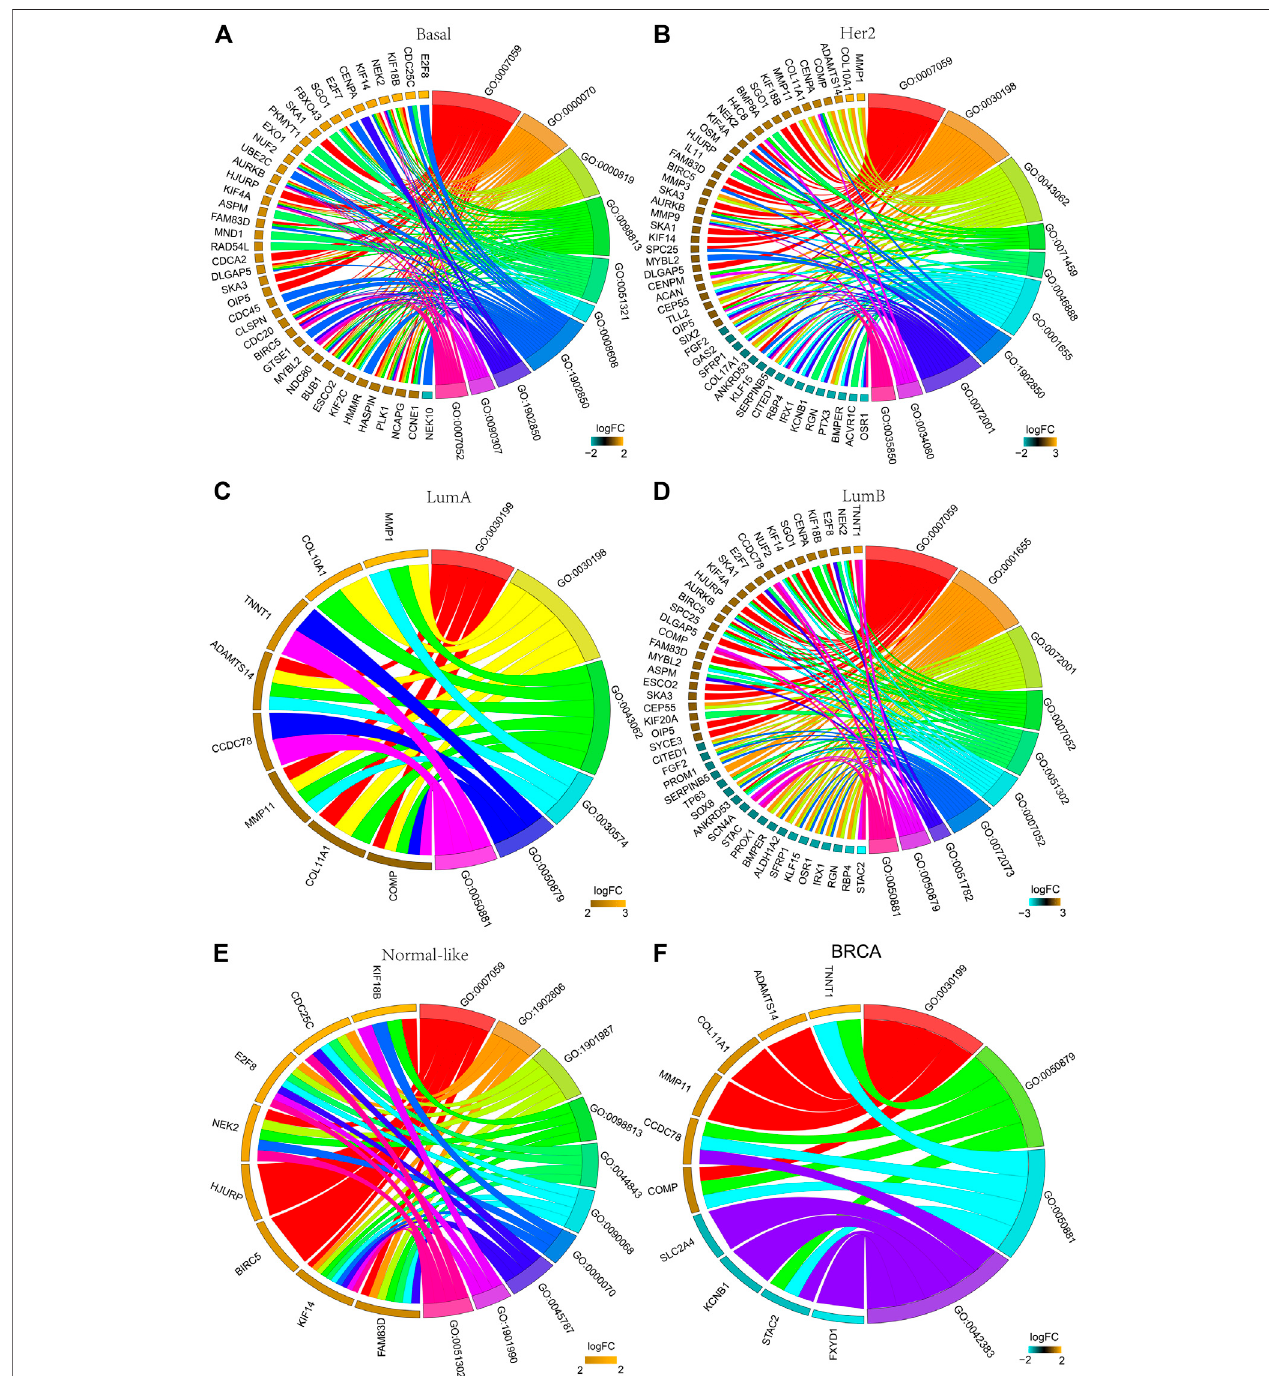
FIGURE3| GOanalysisoftheDEGs.ThechordplotdisplaystherelationshipbetweenDEGandGOterms,representingthenamesofDEGsinthetopenriched10 GO terms. (A) Basal-like; (B) Her2; (C) LumA; (D) LumB; (E) Normal-like; (F) BRCA (all breast cancer). GO:0007059: chromosome segregation; GO:0000070: mitotic sister chromatid segregation; GO:0000819: sister chromatid segregation; GO:0098813: nuclear chromosome segregation; GO:0051321: meiotic cell cycle; GO: 0008608: attachment of spindle microtubules to kinetochore; GO:1901987: regulation of cell cycle phase transition; GO:1902850: microtubule cytoskeleton organization involved in mitosis; GO:0090307: mitotic spindle assembly; GO:0007052: mitotic spindle organization; GO:0030198: ECM organization; GO:0043062: extracellularstructureorganization;GO:0071459:proteinlocalizationtochromosome,centromericregion;GO:0046888:negativeregulationofhormonesecretion;GO: 0001655:urogenitalsystem development; GO:0072001: renalsystem development:GO:0034080: CENP-A containing nucleosome assembly;GO:0035850:epithelial cell differentiation involved in kidney development; GO:0030199: collagen fi bril organization; GO:0030574: collagen catabolic process; GO:0050879: multicellular organismalmovement;GO:0050881:musculoskeletalmovement;GO:0051302:regulationofcelldivision;GO:0072073:kidneyepitheliumdevelopment;GO:0051782: negative regulation of cell division; GO:1902806: regulation of cell cycle G1/S phase transition; GO:0044843: cell cycle G1/S phase transition; GO:0090068: positive regulation of cell; GO:0045787: positive regulation of cell cycle; GO:1901990: regulation of mitotic cell cycle phase transition; GO:0042383: sarcolemma. Frontiers in Molecular Biosciences |